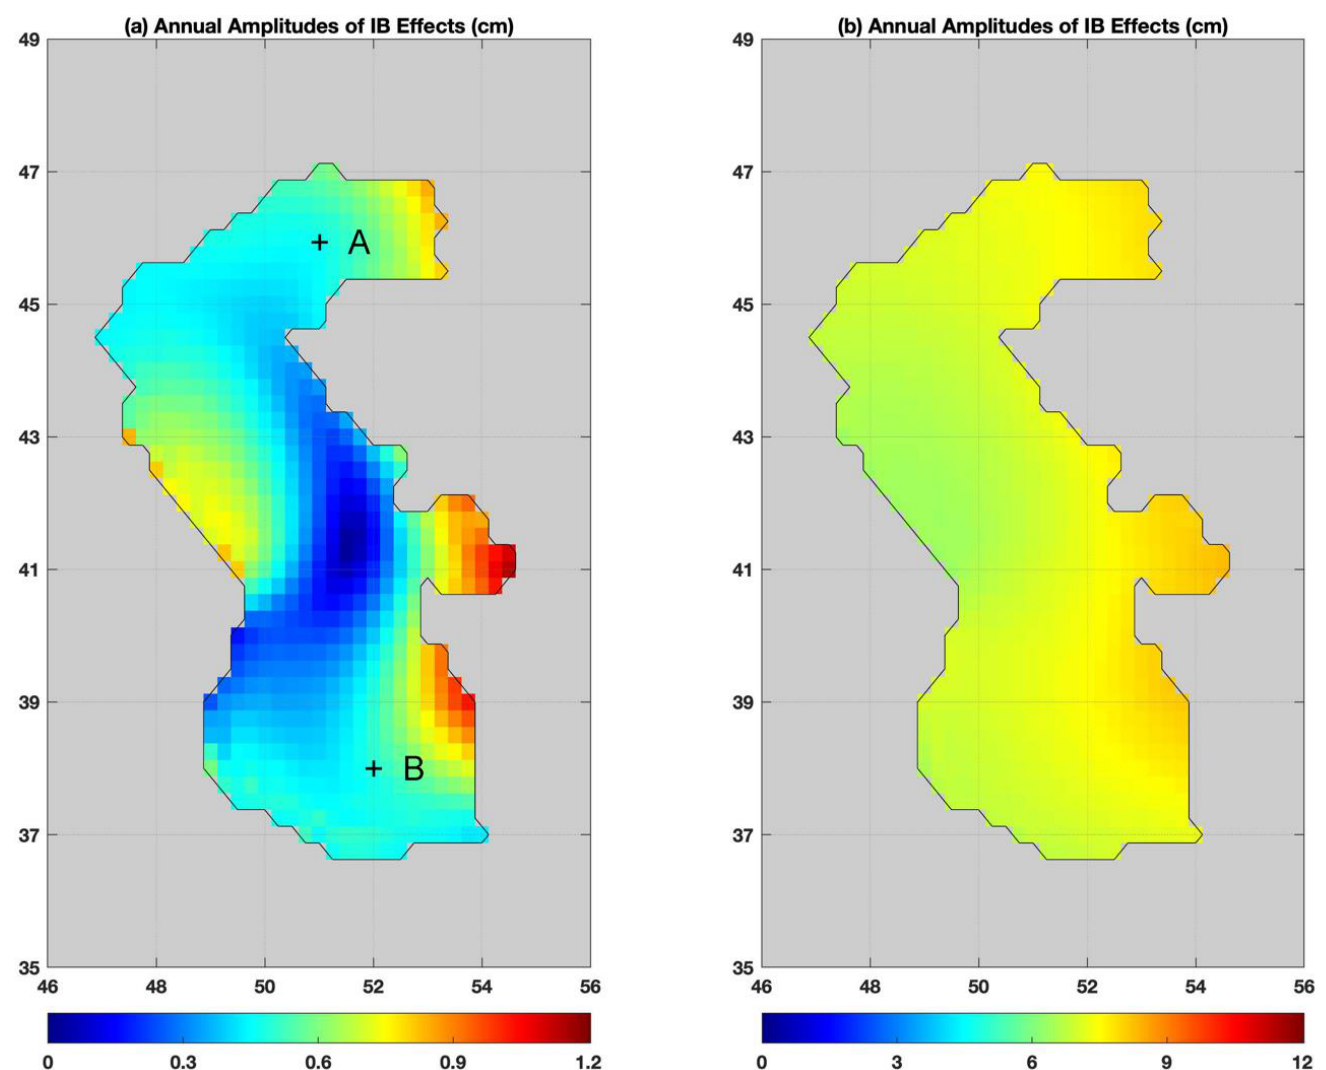
Figure 5. ( a ) Mean annual amplitudes (in cm) of the actual IB effects in Caspian Sea level changes over the period January 1993 to December 2021 based on the ECMWF ERA5 atmospheric model data; ( b ) Mean annual amplitudes of the CMEMS approximate IB effects in Caspian Sea level changes over the period January 1993 to December 2021 (also based on the ECMWF ERA5 atmospheric model data). Note the different color scales used for the two maps. Two grid points A (51 ◦ E, 46 ◦ N) and B (52 ◦ E, 38 ◦ N) are marked by the black “+” in ( a ) for later comparisons.